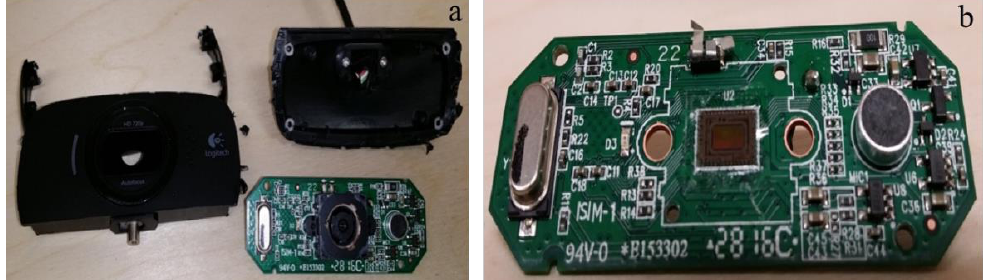
Figure 3. Logitech C525 webcam: ( a ) webcam circuit board and body; and ( b ) sensor of webcam.